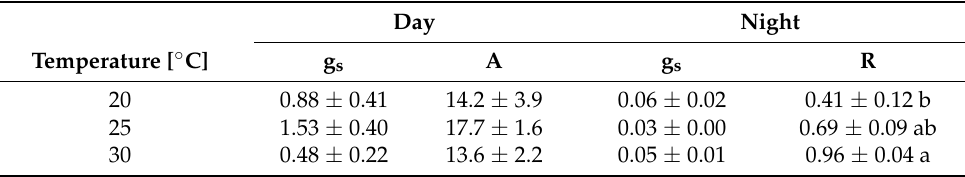
Table 6. Assimilation (A) and respiration rate (R) [ µ mol m − 2 s − 1 ] and stomatal conductance (g s ) [mol m − 2 s − 1 ] during day and night at 3 different constant day/night temperatures and constant RH of 65%. Mean values and standard errors are given. Different letters indicate significant differences at p < 0.05 between temperature treatments.